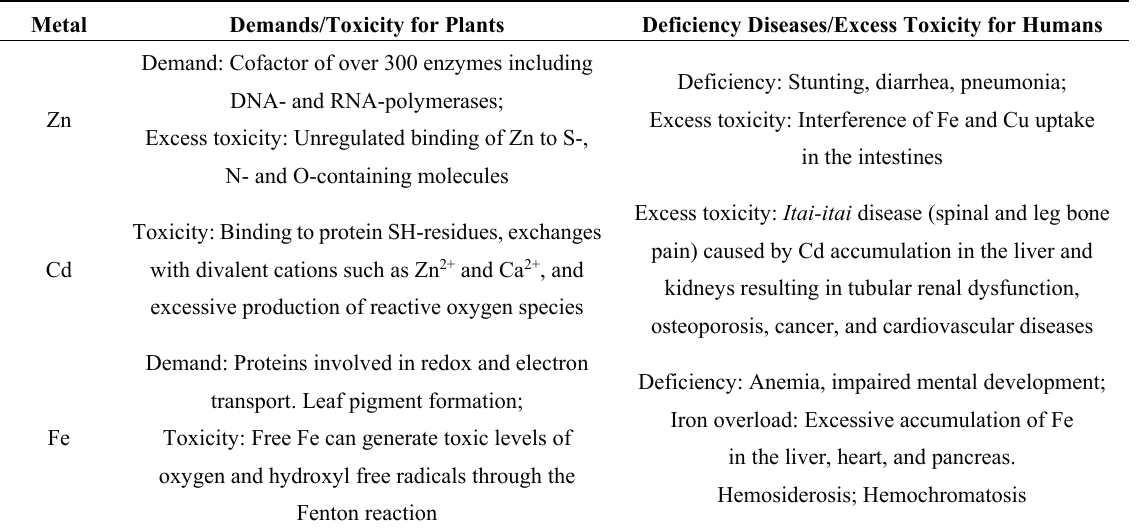
deficiency or excess on